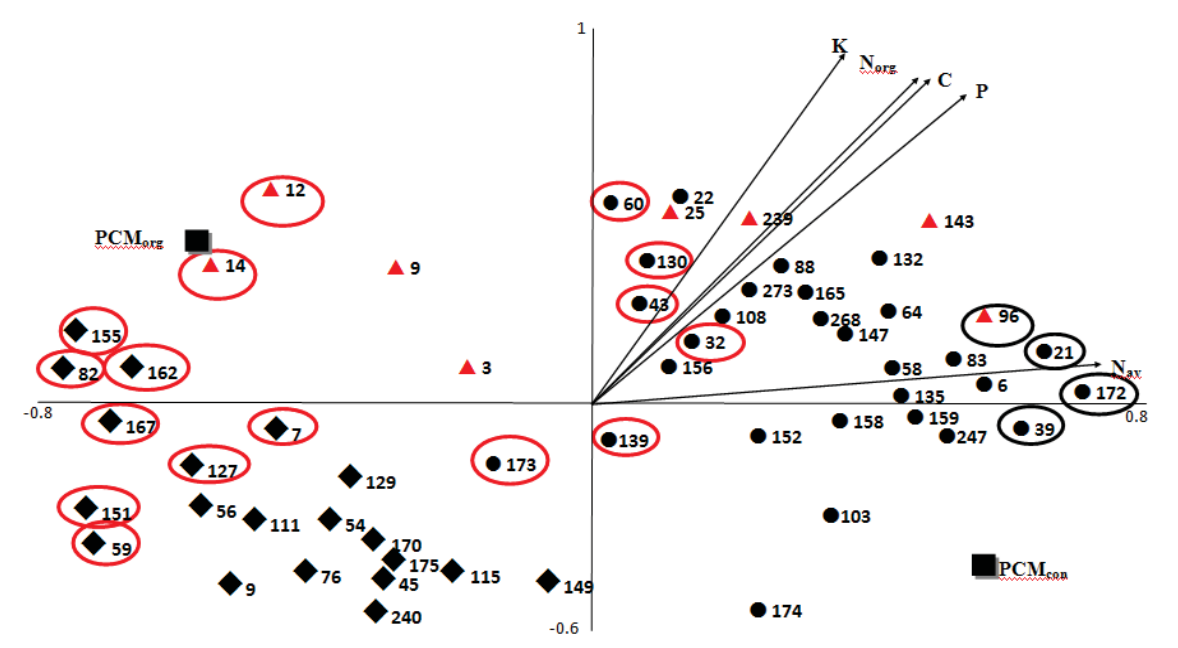
Figure 3. Bi-plot derived from redundancy analysis showing the relationship between protein spots and agronomic factors for ( A ) protein spots affected by fertilization regime (including those that were also affected by previous crop management); ( B ) protein spots affected by previous crop management (including those that were also affected by fertilization regime). Agronomic factors were: categorical variable, , PCM , indicated by black squares; continuous variables, C, P, K, organic and conventional previous soil management, PCM org con organic-N [N ], available N [N ] Symbols indicate protein spots that had significantly increased abundance ( p < 0.01) when no fertilizer org av . (diamonds), high (170 kg N ha − 1 ) composted cattle manure (red triangles) or high (170 N ha − 1 ) composted chicken manure pellets (circles) was applied. The halos indicate protein spots that had significantly increased abundance ( p < 0.01) when crops were grown in soils that were previously under either conventional crop management (black halo) or organic crop management (red halo). Transparent squares (Figure 3B only), correspond to protein spots shown by ANOVA not to be affected by fertilization